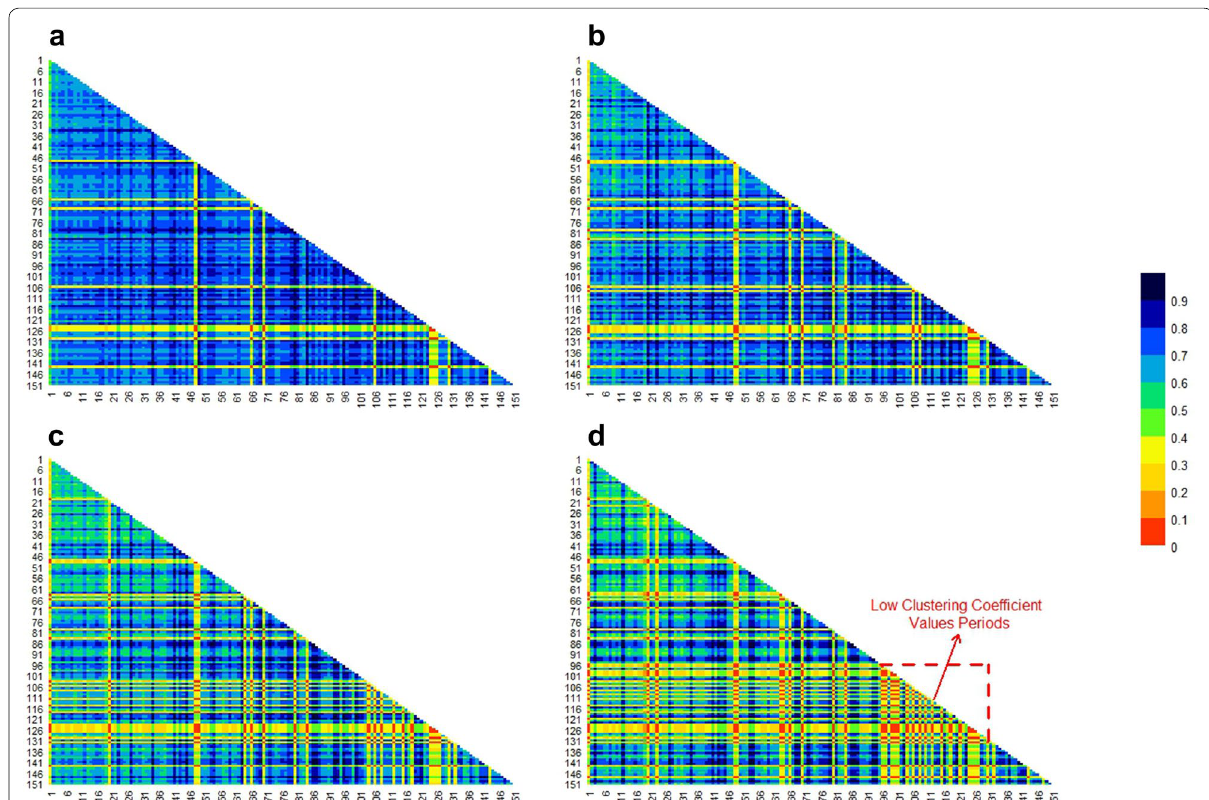
Fig. 7 Average of clustering coefficients of any nodes in the annual streamflow network from the Mississippi River basin for four different thresh- olds ( T ): a T 0.6; b T 0.65; c T 0.7; and d T = = = =